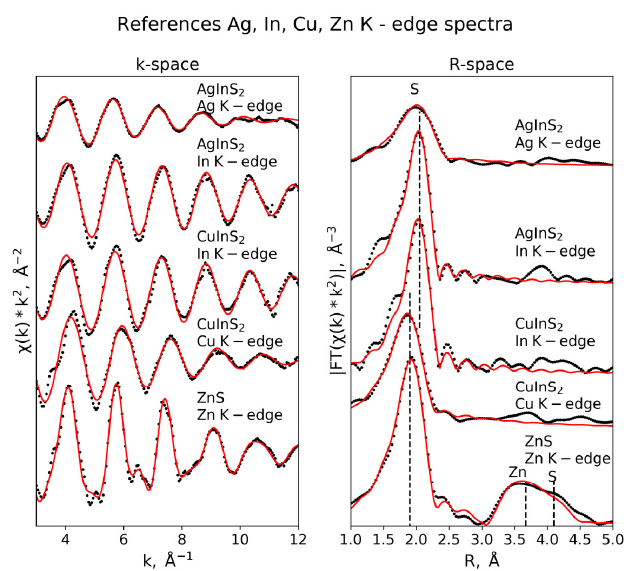
Figure 5. Ag, In, Cu, and Zn K -edge EXAFS spectra of the reference substances. Left panel: oscillation part of EXAFS spectra, k 2 weighted; right panel: absolute values of Fourier transforms (FTs) of EXAFS signals (not corrected for phase shift, which is usually equal to 0.3–0.5 Å). Dotted black line—experiment, solid red lines—fitted spectra (fit results are given in Table 3). Vertical lines indicate the contributions of different groups of scattering atoms. The first peak in the FT curves corresponds to four S atoms in the first coordination shell of metals. The second and third coordination shells of ZnS consist of 12 Zn and 12 S atoms, correspondingly, which contribute to the FT at a distance from 3 to 4.5 Å. The smooth character of the FTs of other references at R > 3 Å suggests distortion of the atomic structure of the distant coordination shells.